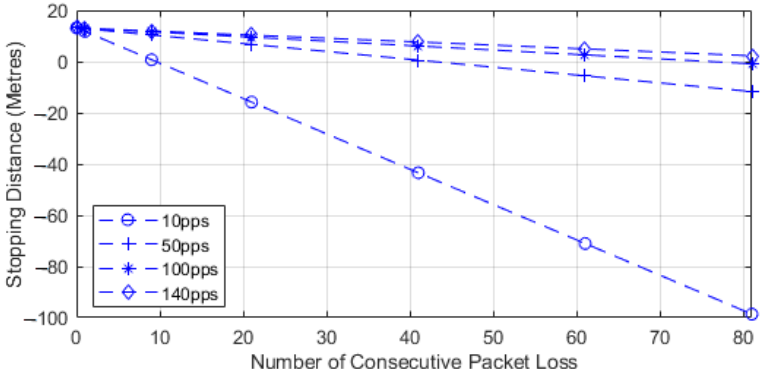
Figure 16. Thirty miles per hour (48.27 km/h) reduction in stopping distance.